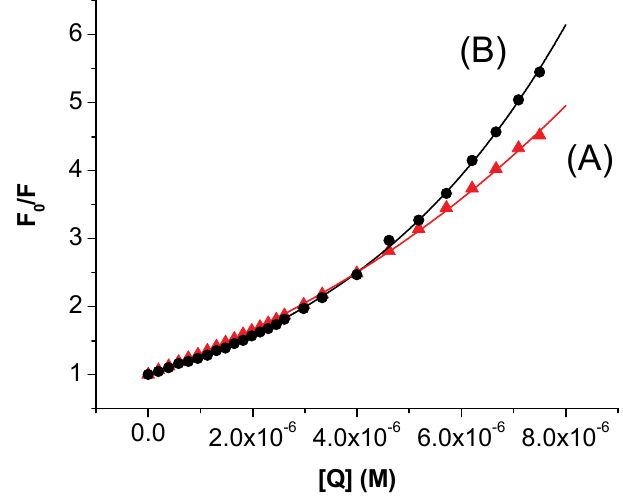
Figure 4. Stern-Volmer plots for the systems HSA— I (A) and BSA– I (B); [HSA] = [BSA] = 3 × 10 -6 (M); A) r 2 = 0.999; B) r 2 = 0.999; the plots represent the best fits of the experimental points using Equation (2).